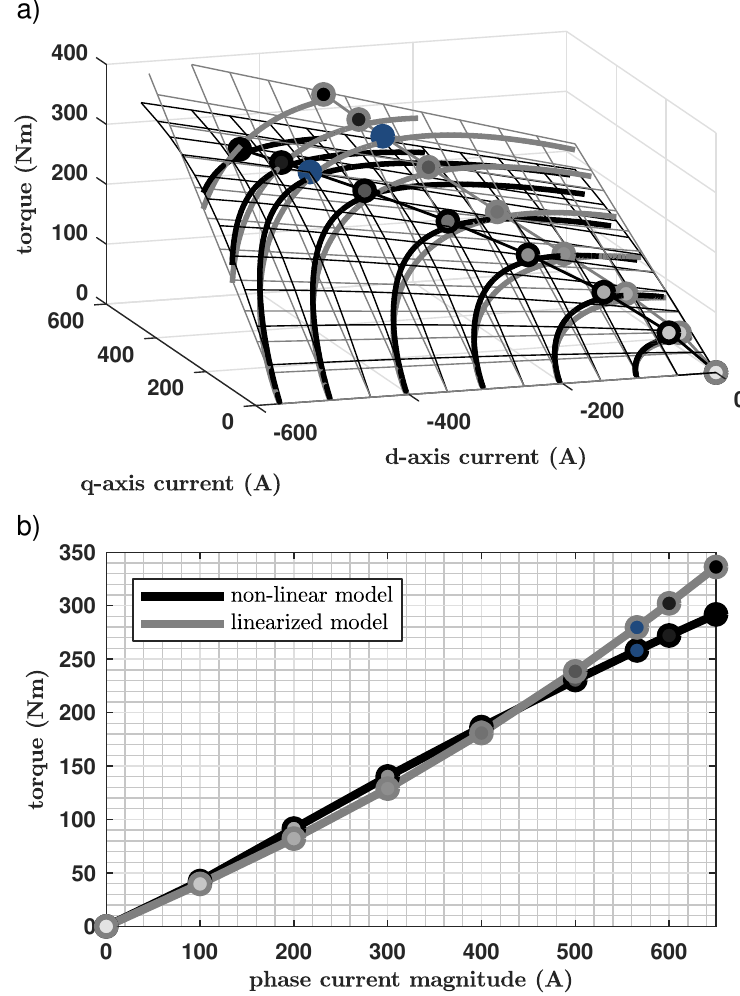
Figure 11. Comparison of the partial load torque vs. current magnitude for the BMW i3 traction drive calculated with two different methods, i.e., a numerical search algorithm based on the non-linear machine model (black) and analytical equations based on the linearized machine model (gray): ( a ) operation points locus at torque surfaces, ( b ) torque vs. phase current magnitude. The filled dots are the operation points calculated for different phase current limitations. The points corresponding to the actual peak phase current of the drive (i.e., 565.7 A) are marked with